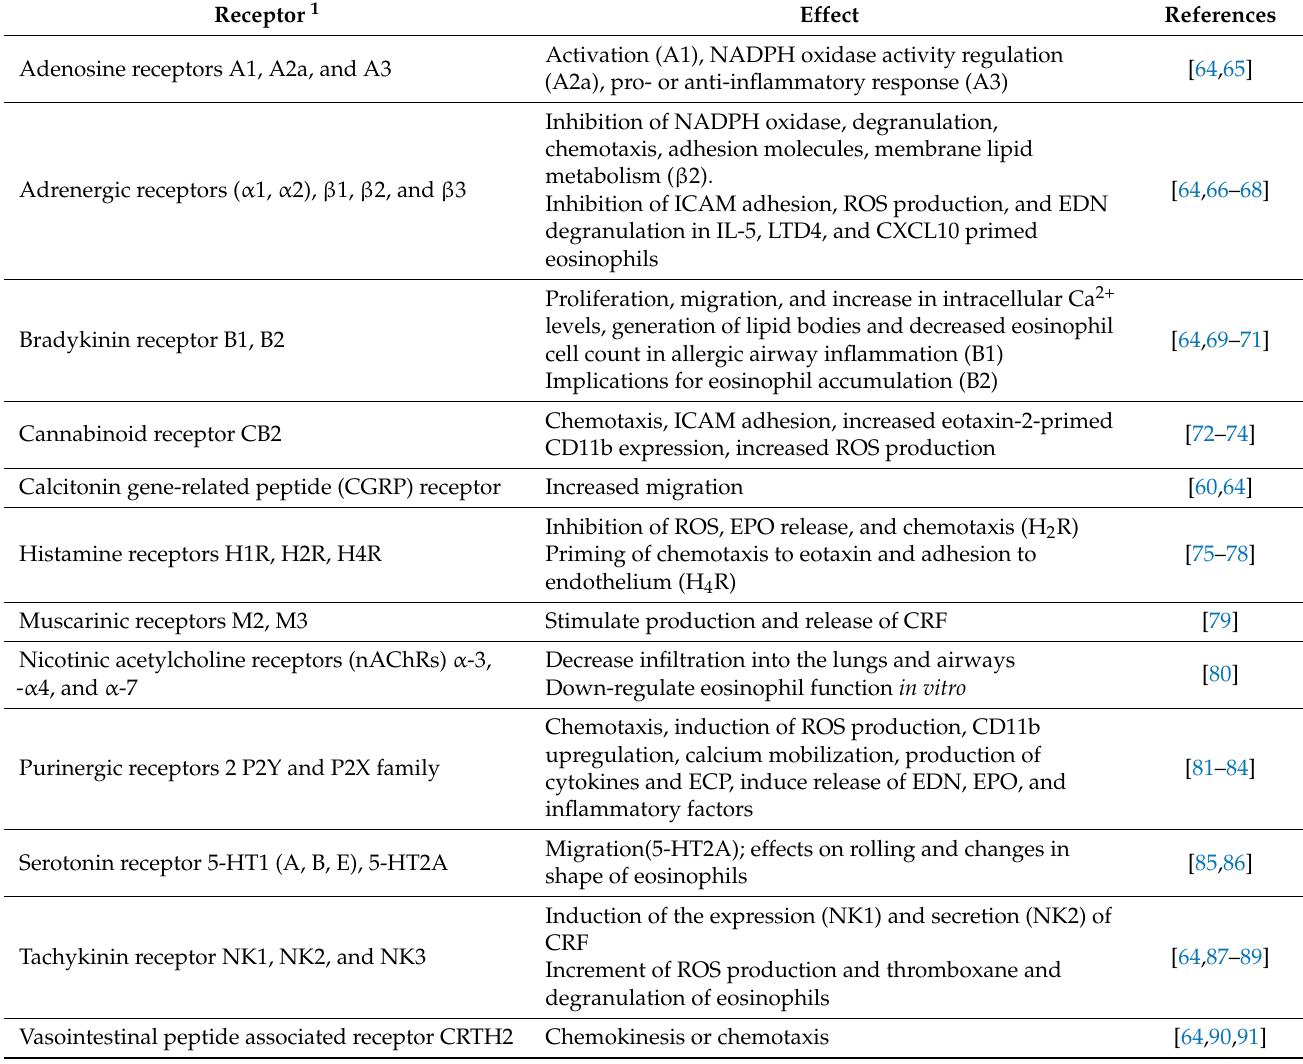
Table 2. Neuropeptide receptor expression and effects on